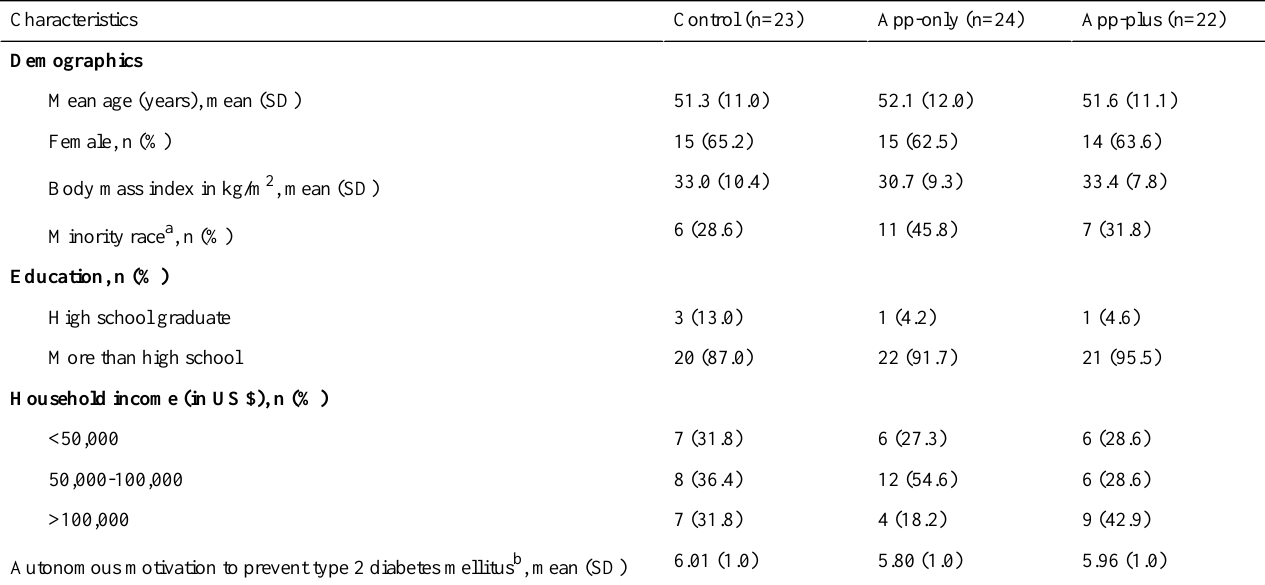
Table 1. Baseline characteristics of study participants.